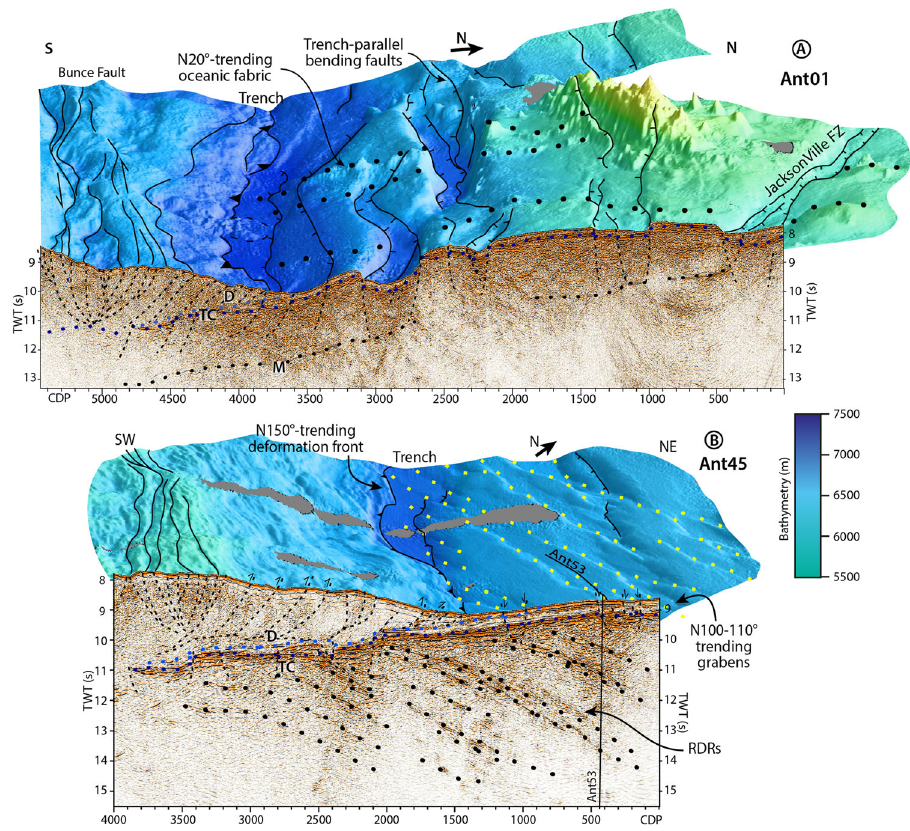
Fig. 2 3D seismic-bathymetry blocks at magmatically robust and tectonically dominated segments. Three-dimensional seismic-bathymetry views illustrating typical oceanic basement ( A line Ant01) and the spectacular, tectonically dominated, exhumed oceanic basement ( B line Ant45) located outside and inside the Jacksonville Patch, respectively. D, TC, and M stand for Decollement, Top of the oceanic Crust, and Moho, respectively. Black and yellow dotted lines underline the Ridgeward-Dipping oceanic-basement Re fl ectors (RDRs) and the oceanic grabens direction, respectively. Vertical Exaggeration 1:3.5. Additional 3D blocks are in Supplementary Fig.